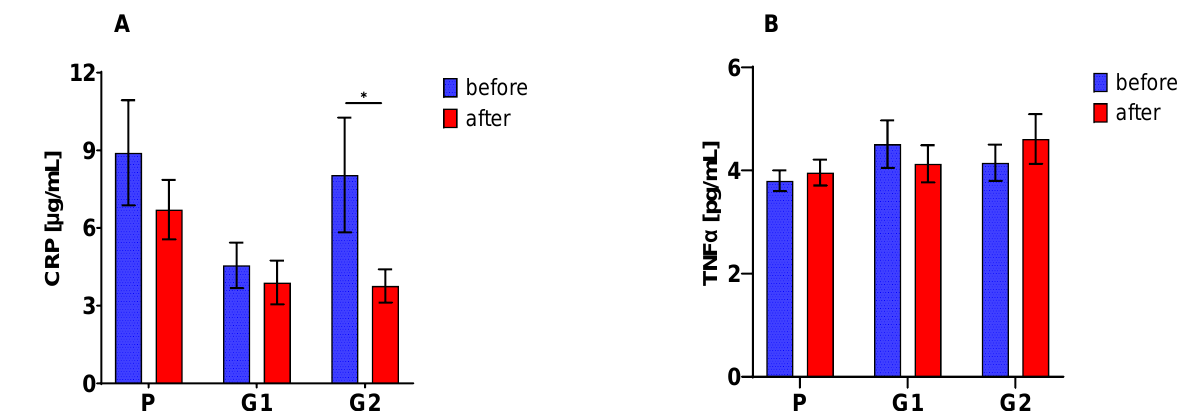
Figure 1. Serum C-reactive protein (CRP) ( A ) and TNFα ( B ) concentration (mean ± SE); The asterisk (*) denotes a statistically significant difference after vs. before dietary intervention, set at p < 0.05.